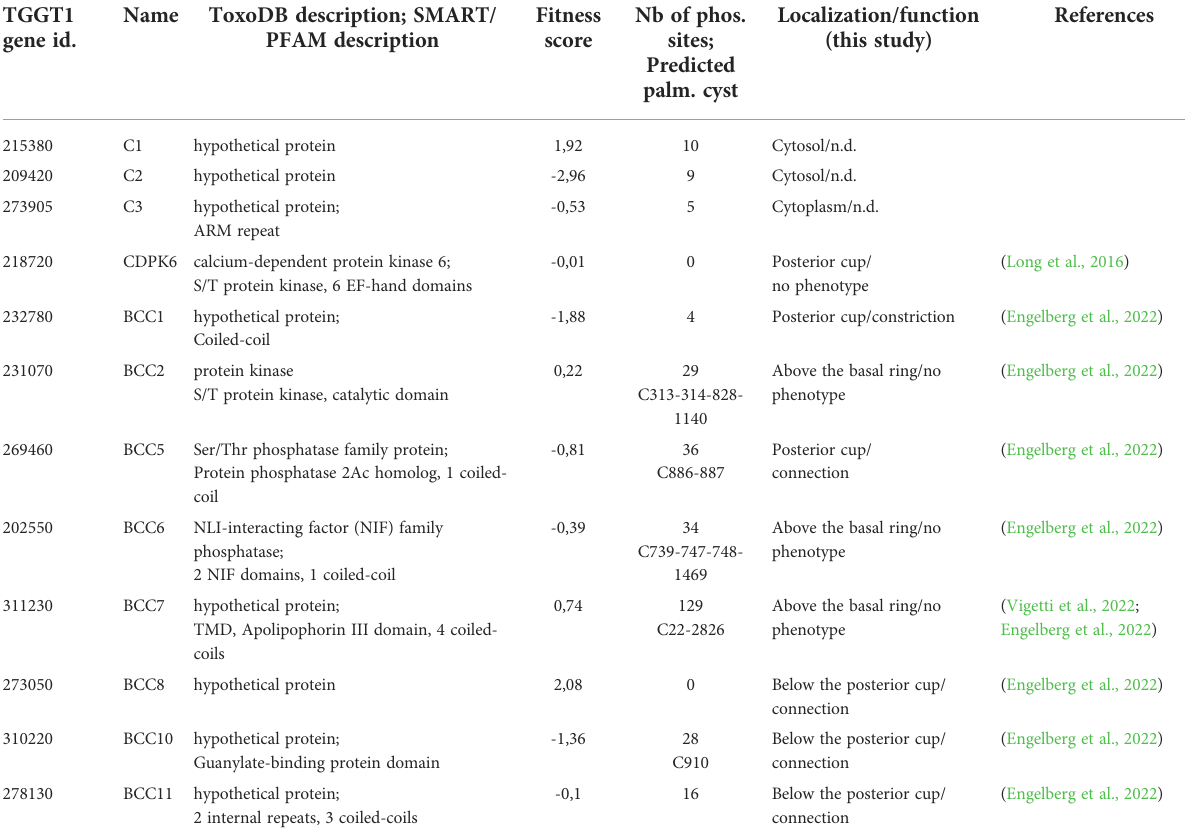
TABLE 1 Summary of the information about the 12 candidates investigated in this study. TGGT1 gene